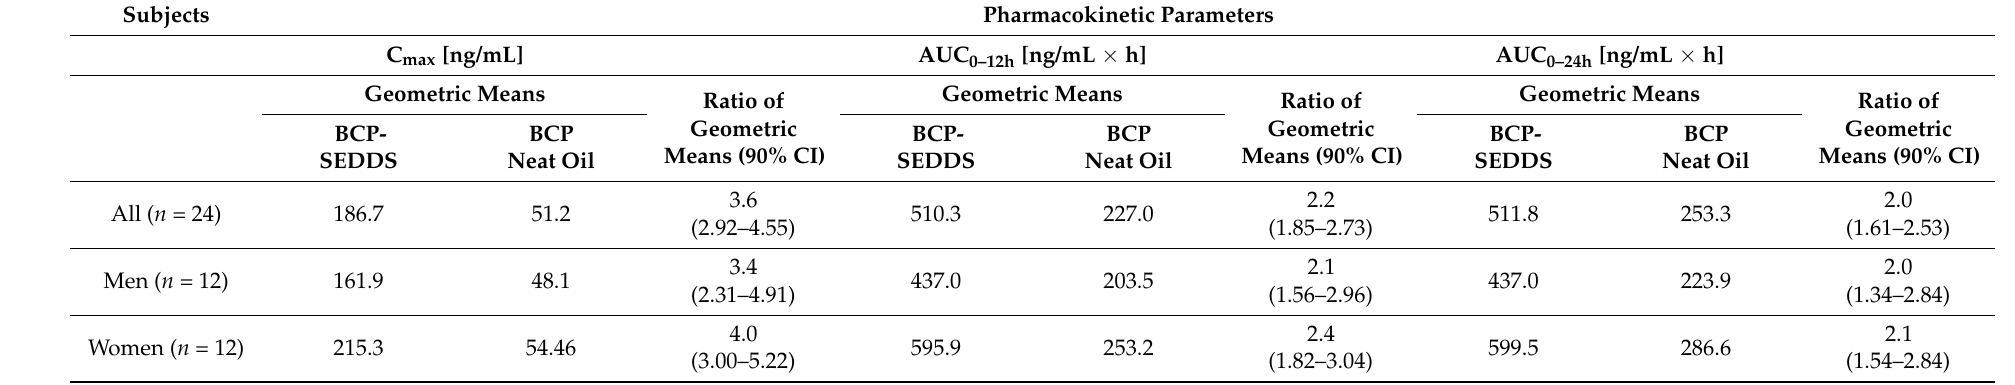
Table 3. Ratios of geometric means for the pharmacokinetic parameters after a single oral dose of 100 mg BCP. BCP was administered either as self-emulsifying